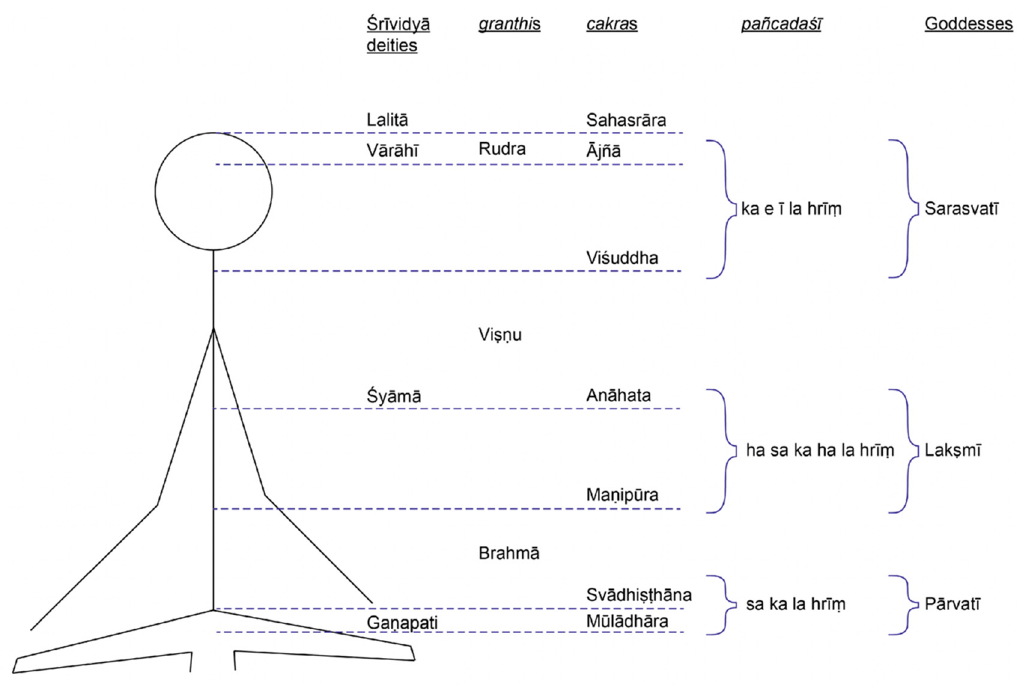
Figure 2. Superimposition of body, granthi s, pañcada śī mantra , deities, cakra s. Credit: Nirbhay Sen.